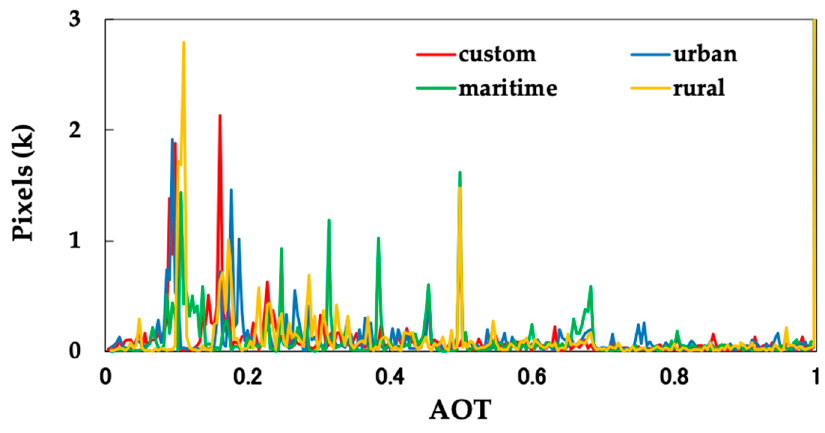
Figure 9. Comparison of τ map from custom aerosol model and conventionally-used typical aerosol models (data from 2020).